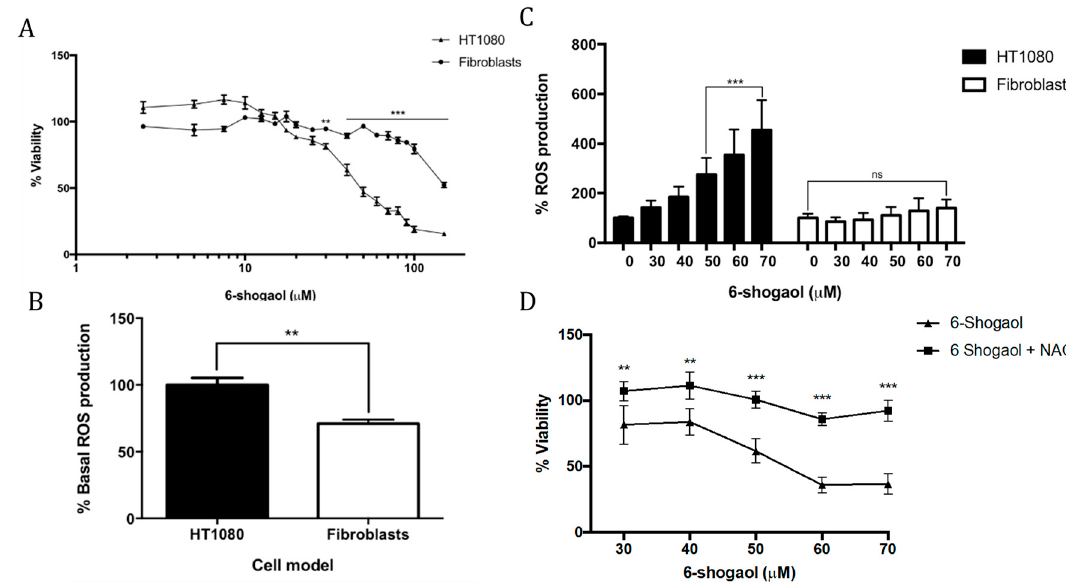
Figure 1. 6-Shogaol effects on cancer and normal cells. ( A ) HT1080 and fibroblasts derived human periodontal ligament (HPdLF) cell viability; ( B ) Basal reactive oxygen species (ROS) production in HT1080 and HPdLF cells; ( C ) Effect of 6-shogaol exposure in reactive oxygen species (ROS) production in HT1080 and HPdLF cells; and, ( D ) HT1080 and HPdLF cell viability co-treated with N-acetyl cisteine (NAC) and 6-shogaol. ** p = 0.01; *** p = 0.001.